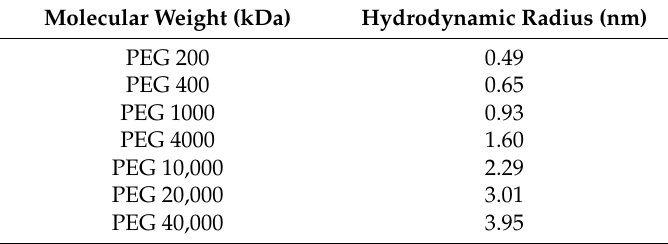
Table 2. Molecular weights and hydrodynamic radius of PEG used in MWCO study.